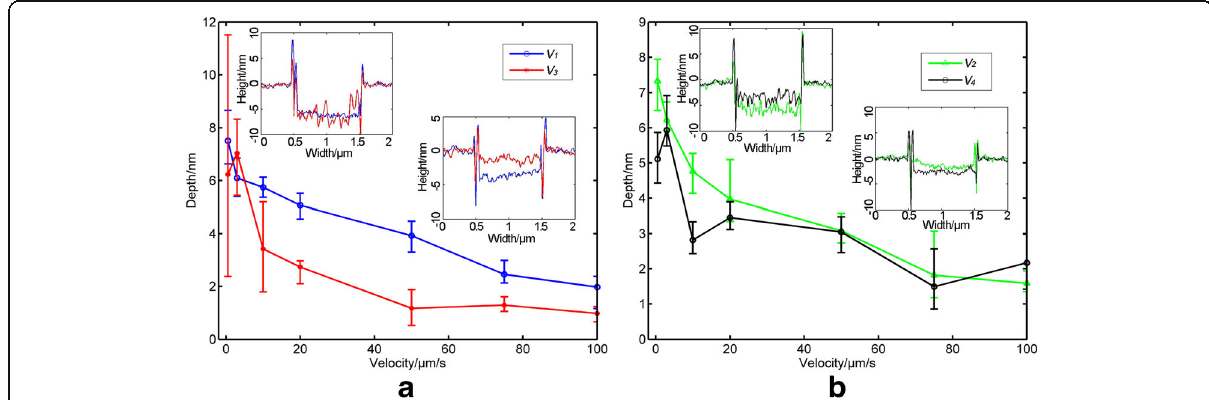
Fig. 4 Dependence of groove depth on the scratching velocity in typical scratching directions: a V 1 and V 3 , parallel to the long axis of the cantilever; b V 2 and V 4 , perpendicular to the long axis of the cantilever. The insets show the cross-section of nanogrooves for scratching velocities of 0.5 and 50 μ